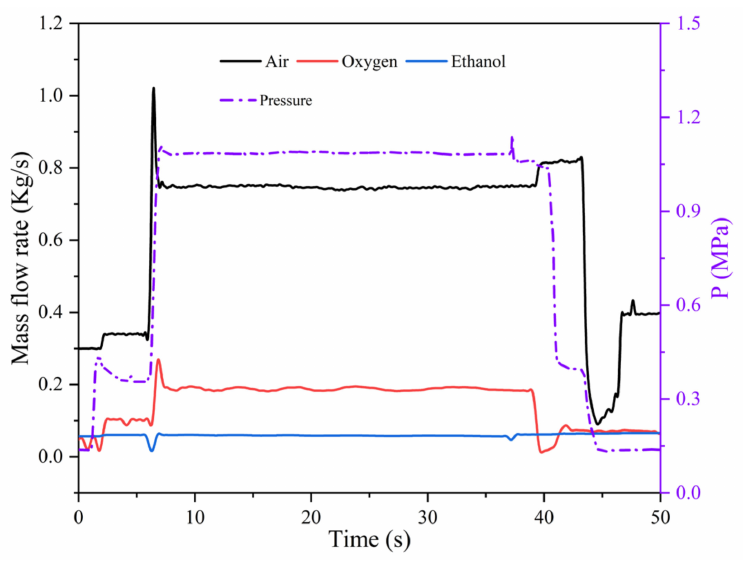
Figure 6. Schemes follow the same